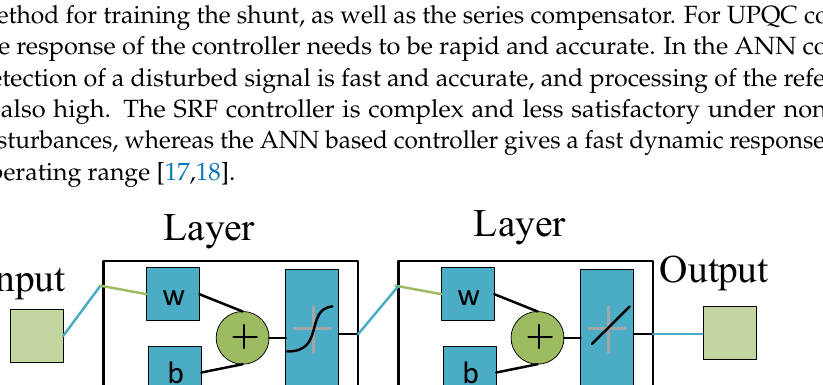
Figure 6. ANN structure.